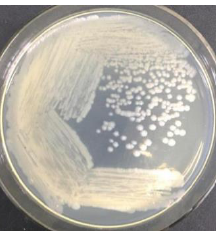
Figure 1. The colony morphology of